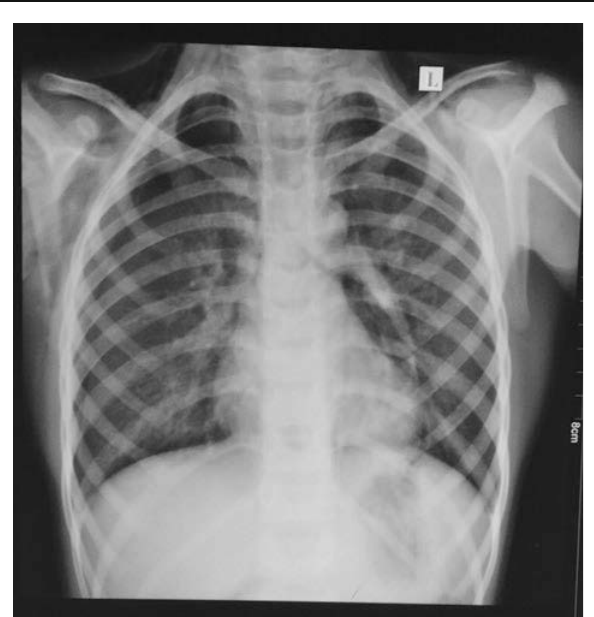
Chest radiograph showing